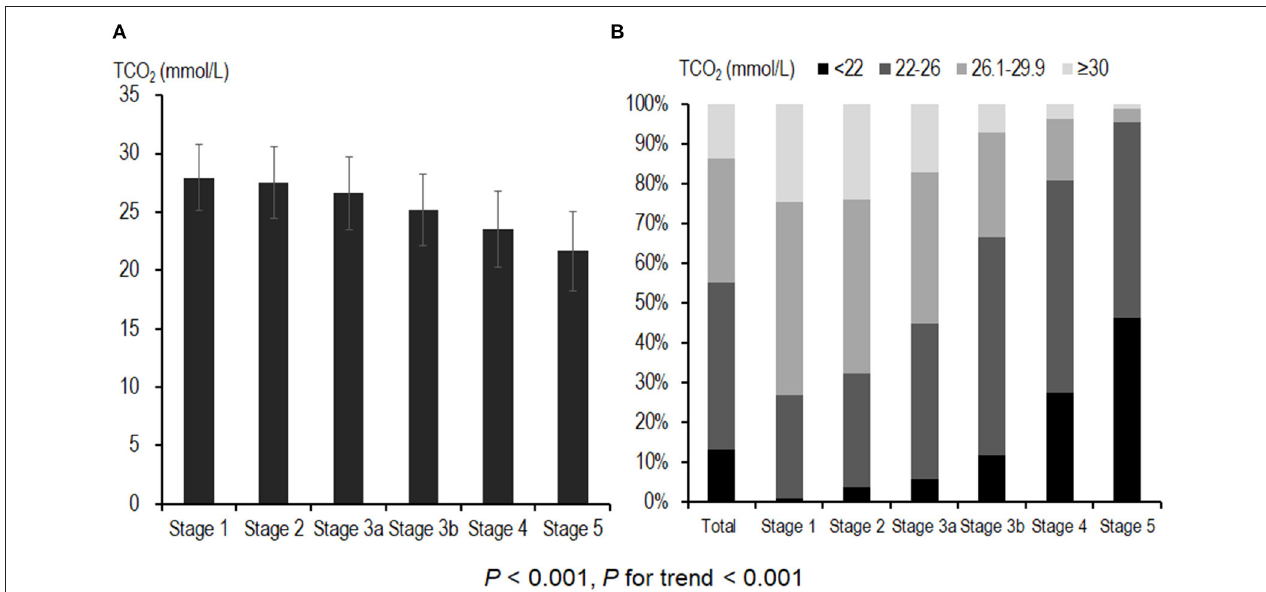
FIGURE 1 | Distribution of serum bicarbonate and prevalence of metabolic acidosis across CKD stages. (A) Advanced CKD stages were associated with lower serum bicarbonate levels. A total of 240 (13.2%) patients had metabolic acidosis. (B) The prevalence of metabolic acidosis was higher in patients with advanced CKD; 111 (27.6%) and 51 (46.4%) of CKD stage 4 and stage 5 patients, respectively, exhibited metabolic acidosis. CKD, chronic kidney disease; TCO 2 , total carbon dioxide.